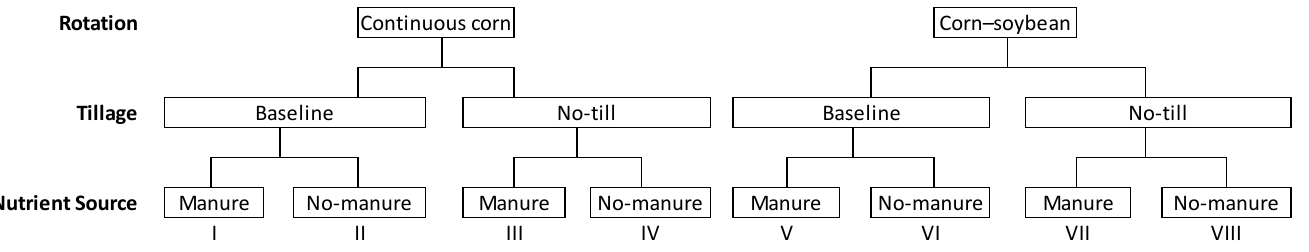
Figure 2. Types of representative farms used in economic simulations.